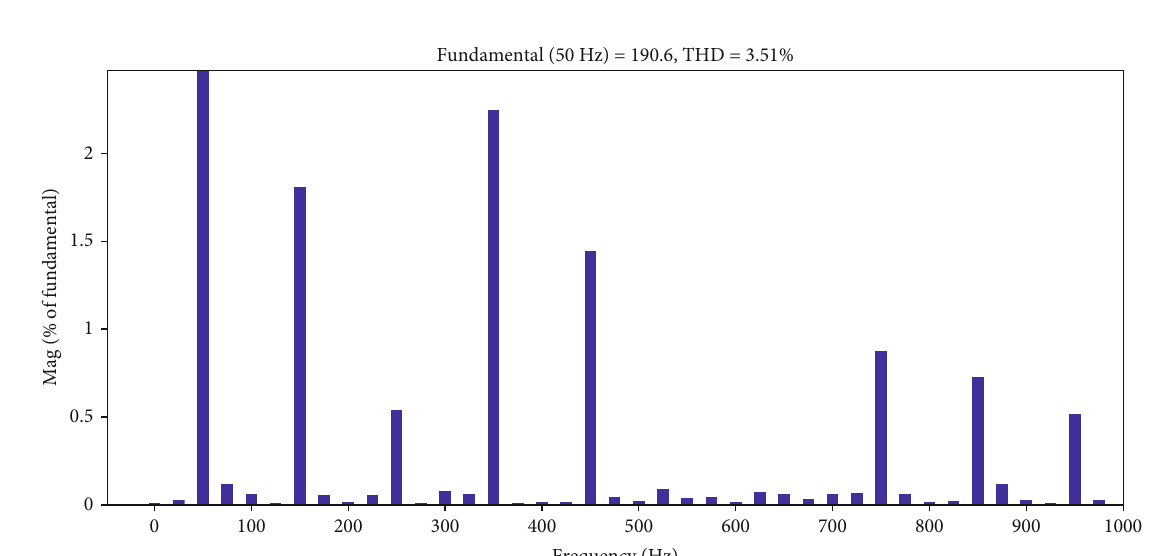
Figure 38: Input MLI signal.